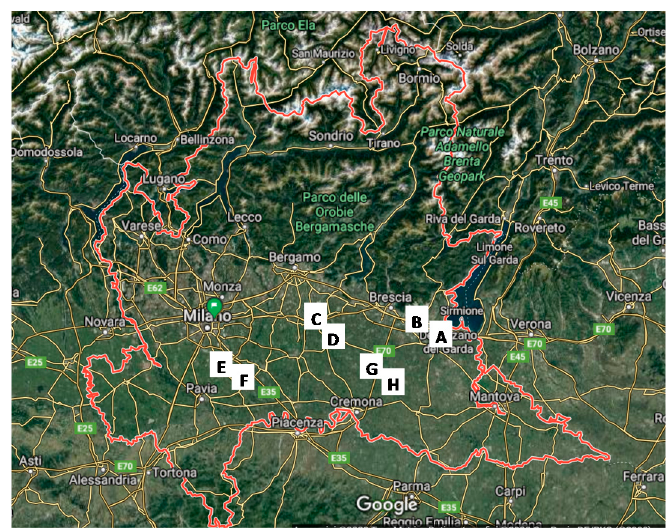
Figure 1. Map of Lombardy region in which the localization of the eight sampled farms is reported. Farms A and B are in Brescia province; farms C, D, G and H are in Cremona province; farm E is in Pavia province and F in Lodi province.